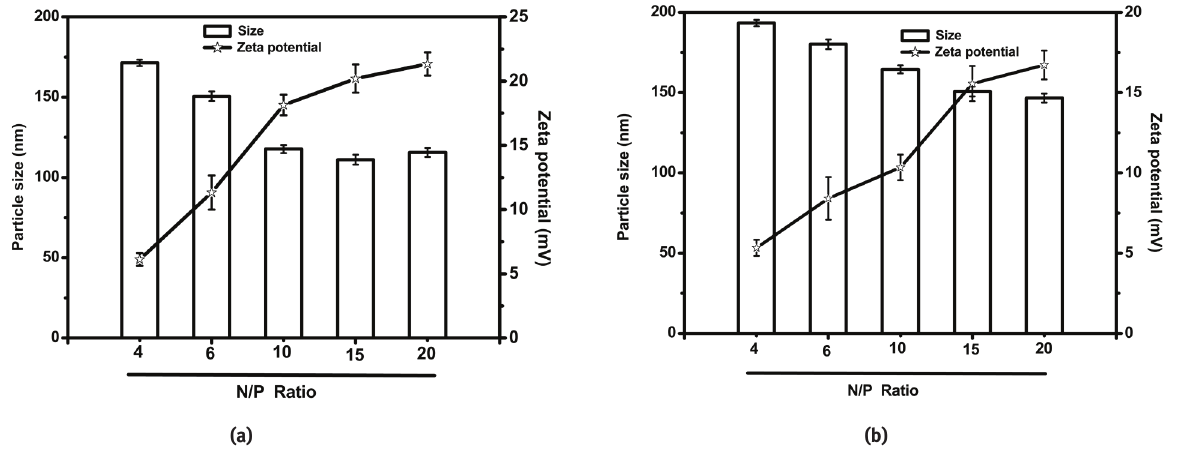
Figure 3: The particle sizes, zeta-potentials of PEG-PEI/miR-221 (a) and PEG-PEI/miR-222 (b) polyplexes formed at different N/P ratios. Measurements were performed at room temperature, and data shown in mean±SD (n=5).